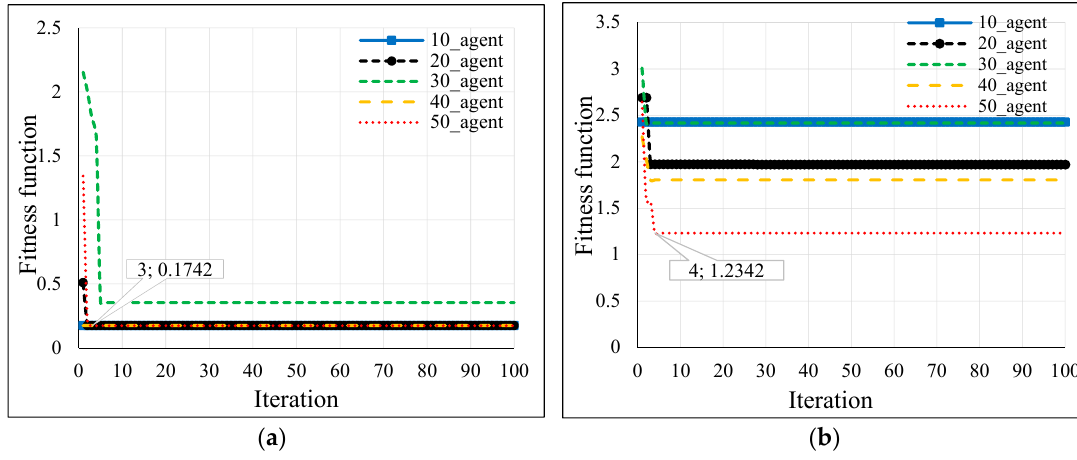
Figure 13. GSA fitness function versus iteration for ( a ) outdoor and ( b ) indoor velodromes.